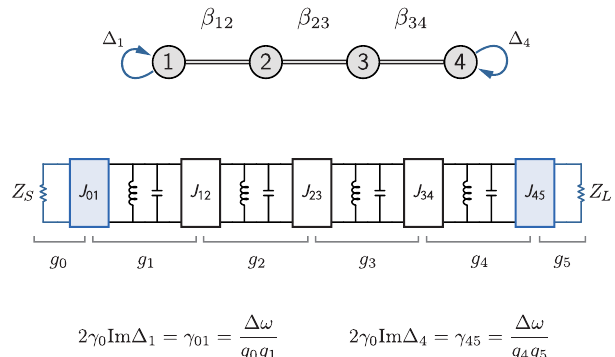
FIG. 13. Correspondence between a graph representation of a parametrically coupled network and a coupled-resonator band- pass filter. The β jk are the coupling elements in the coupled-mode matrix representation, J jk are admittance inverters, and g i are filter prototype coefficients. The port dissipation rates γ are embedded in the imaginary part of the self loops on modes 1 and